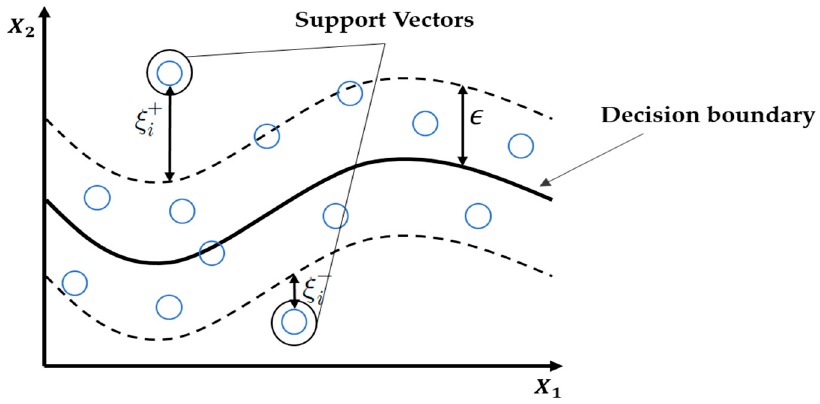
Figure 3. Structure of a Support Vector Regression.